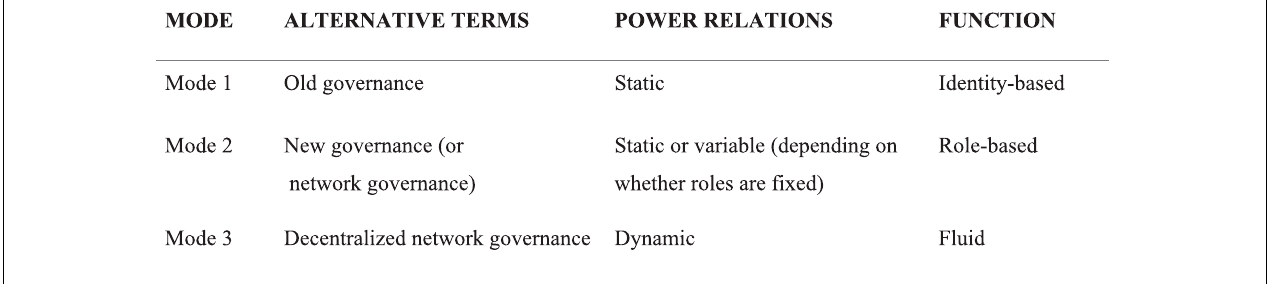
FIGURE 4 | Overview of modes of